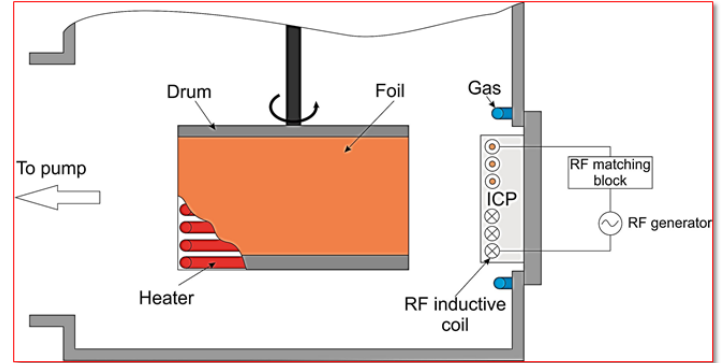
Figure A1. Schematic illustration of an inductively coupled plasma chemical vapor deposition (ICP CVD) system coupled to a roll-to-roll (RtR) apparatus, i.e., new ICP CVD Roll-to-Roll technology, which was used for the formation of vertically oriented graphene (VOG) nanostructures on a moving copper foil substrate. This system was connected to a power source, a mass flow controller (Pneucleus Technologies LLC, Hollis, NH, USA), two gas inlets, a radio frequency (RF) generator (13.56 MHz) and a matching block (MB), a drum and a heater designed by IZOVAC TECHNOLOGIES Ltd. The